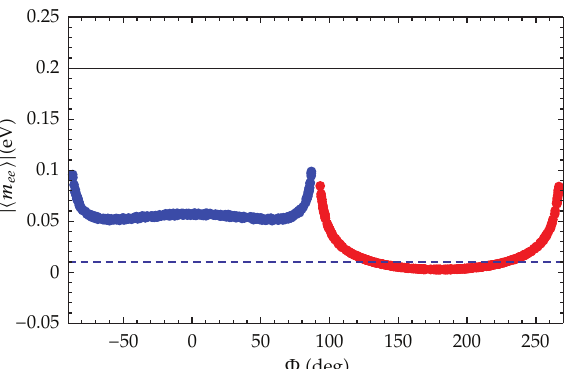
Figure 2: Prediction of the e ff ective neutrino mass |(cid:2) m ee (cid:3)| responsible for 0 ν 2 β decay as a function of φ by the 1 σ experimental constraints (cid:2) 2.9 (cid:3) . The blue (cid:2) dark (cid:3) and red (cid:2) light (cid:3) curves correspond to the IH and NH spectra.